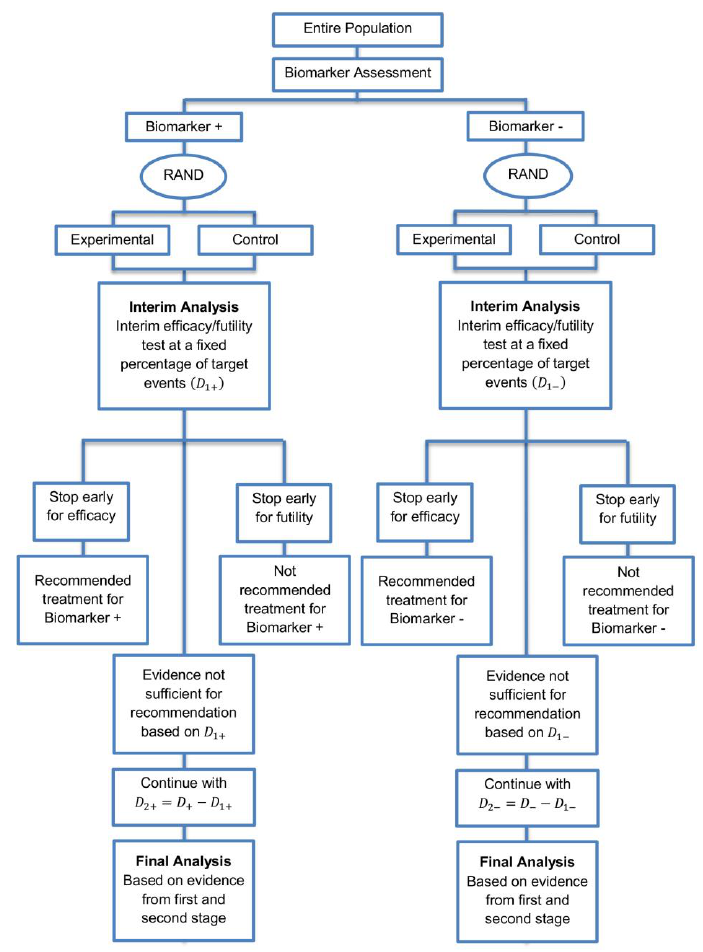
Figure 4. Adaptive parallel subgroup-specific design. “RAND” refers to randomization of patients. 𝐷 1+ and 𝐷 1− correspond to the target number of events of the biomarker-positive subgroup and biomarker-negative subgroup respectively at the first stage of the study. 𝐷 + and 𝐷 − correspond to the total required number of events of the biomarker-positive subgroup and biomarker-negative subgroup respectively which are planned according to the non-adaptive approach. 𝐷 2+ and 𝐷 2− correspond to the number of events of the biomarker-positive subgroup and biomarker-negative subgroup respectively at the second stage of the study.